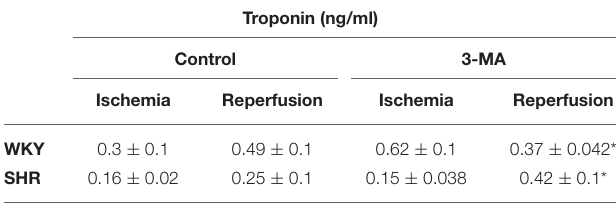
TABLE 3 | Effect of blockage of autophagy on troponin release in WKY and SHR.